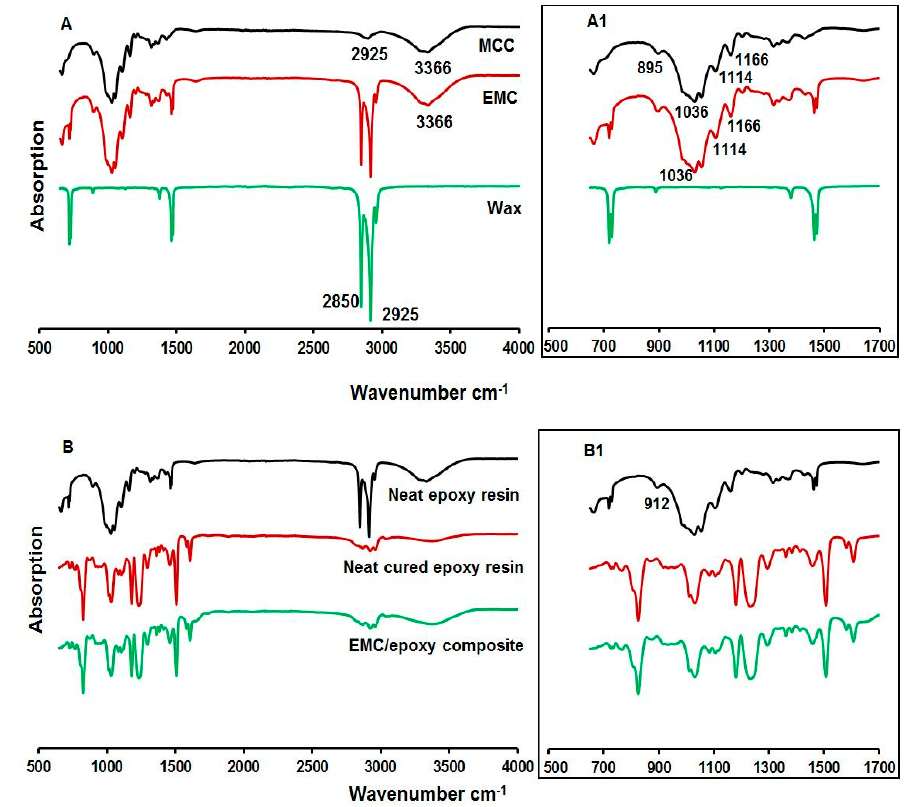
Figure 6. FTIR spectra of MCC, EMC and wax ( A and zoomed A1 ); and neat epoxy resin, neat cured epoxy resin and EMC reinforced (3% EMC loading) epoxy resin ( B and zoomed B1 ).